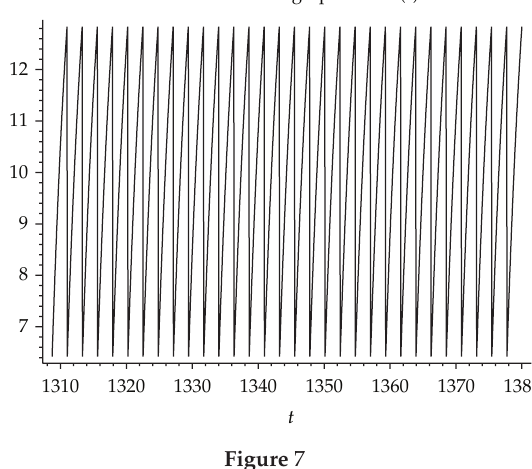
The time series graph for t - S ( t